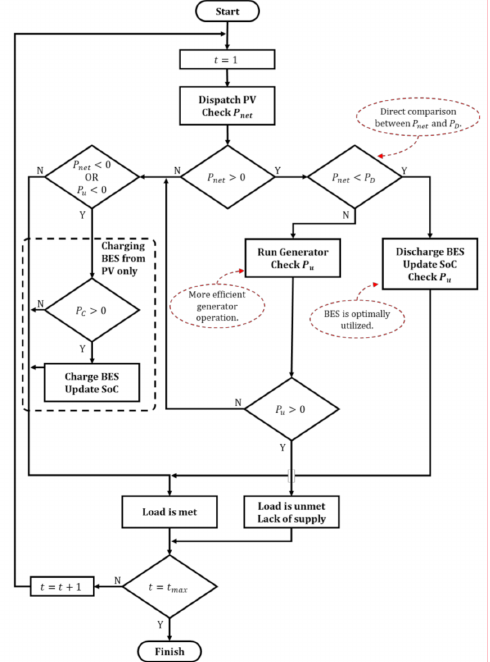
Figure 8. Optimal BES Discharge (OBD) control strategy. The decision to utilize BES is by directly comparing P net to the available BES power ( P D ) instead of examining the BES’s SOC, such as in other